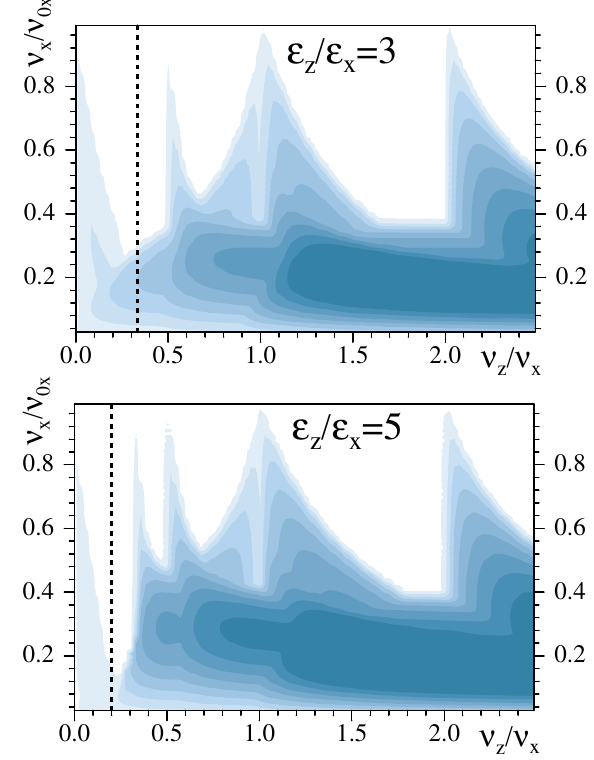
FIG. 12. (Color) Stability charts for emittance ratios 3 and 5 (same units as previous